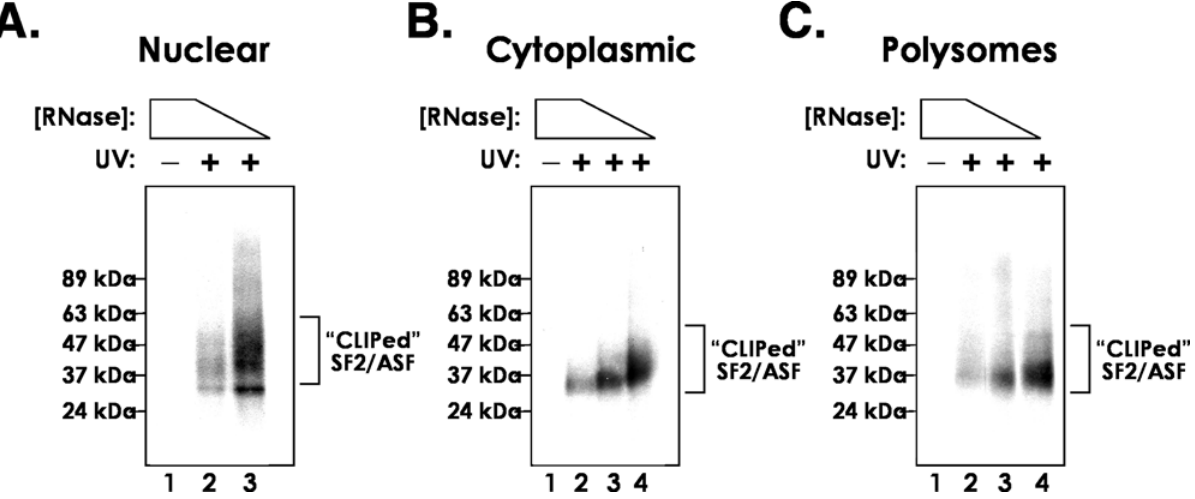
Figure 1. Cross-linking immunoprecipitation of SF2/ASF from different HEK293T cellular fractions. SF2/ASF-RNA complexes, indicated by the bracket, were visualized by autoradiography. Positions of molecular weight standards are given at the left of each panel and exposure of cells to ultra violet radiation (UV) is indicated by + or 2 .